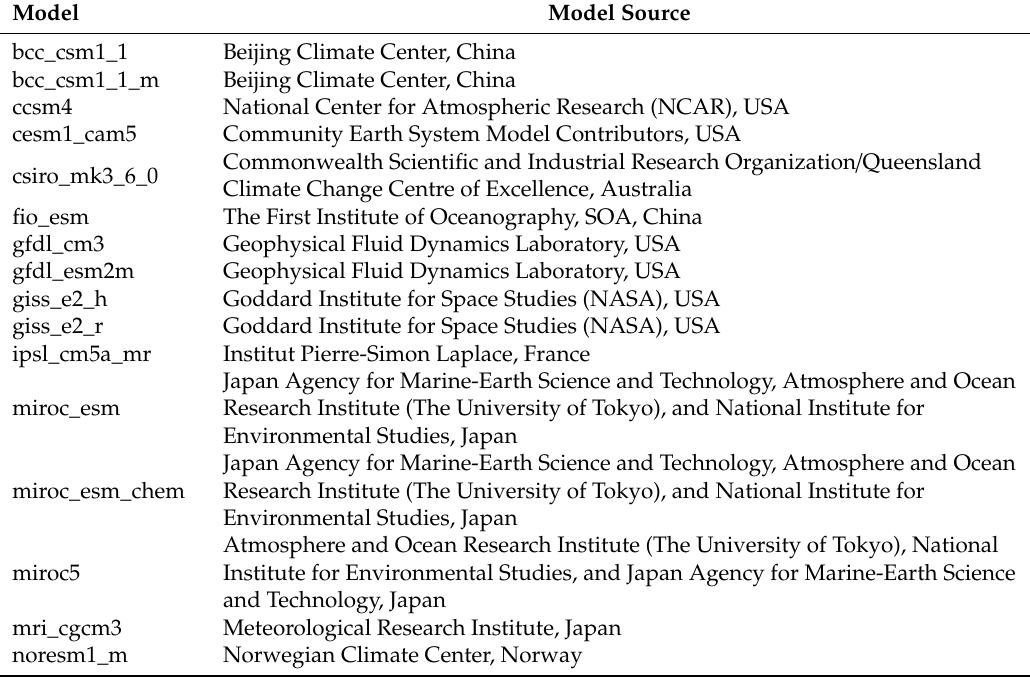
Table 4. List of climate models used in the